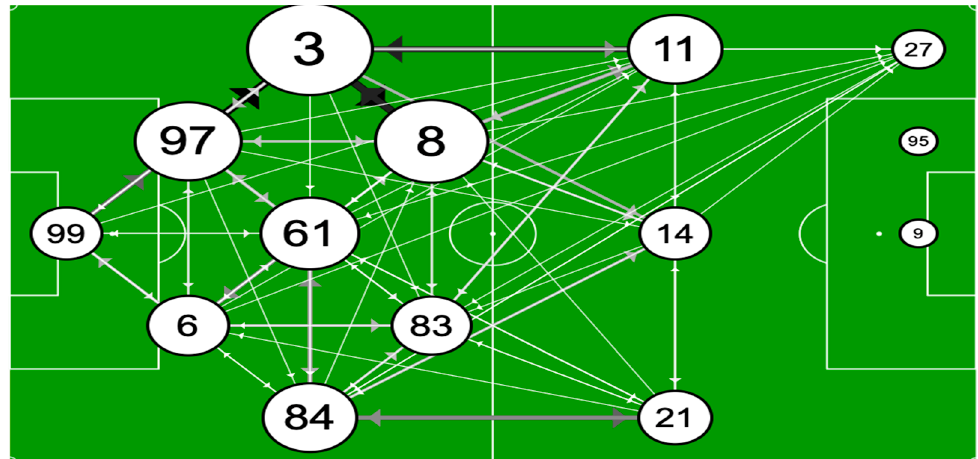
Figure 1. Network display results from team A in first half of game .